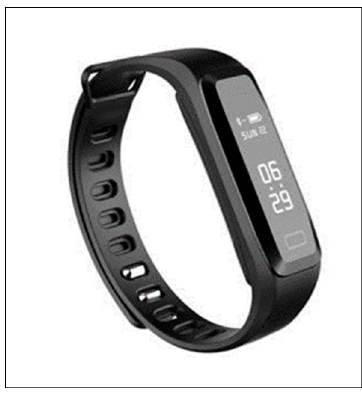
Figure A1. Accuracy ( a ) and loss ( b ) of the proposed model per epoch.